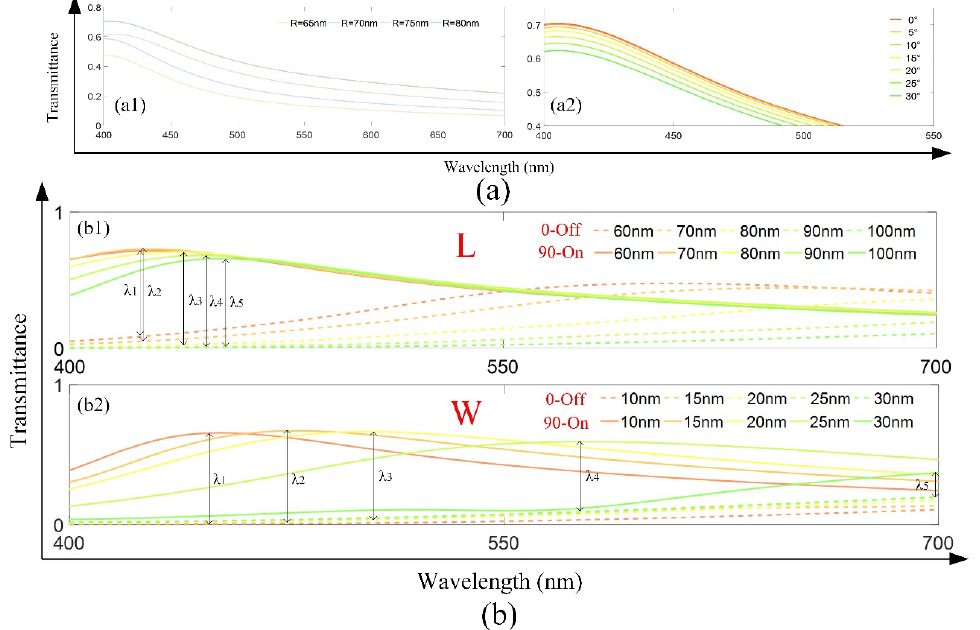
Figure 4. Transmittance diagram in different situations. ( a1 ) When there is no metal strip in the hollow hole, the radius R of the hollow hole is changed; ( a2 ) when there is no metal strip in the hollow hole, angle between incident light and normal direction of material surface; ( b1 ) when the number of the metal strips is three, the L changes; ( b2 ) when the number of the metal strips is three, the W changes. On the other hand, the length L and width W of the metal strip are changed when the number of the metal strip is three in Figure 4b. As shown in Figure 4(b1), when the polarization direction is parallel to or perpendicular to the X-axis , the transmission peak shows a slight red-shift as L increases from 60 nm to 100 nm. In general, when the length of the metal strip increases, the coupling degree between the metal strip and the edge of the hollow circular hole increases; at the same time, the length of the FP cavity increases, resulting in the red-shift of the transmission peak. The difference is that when the width increases, the space in the hollow circular hole decreases, which makes the effective refractive index n eff in the hollow hole increase, leading to the red-shift of the transmission peak, especially when the polarization direction is 90°. Similarly, when W increases from 10 nm to 30 nm, the red-shift occurs whatever the polarization direction is 0° or 90° in Figure 4(b2).